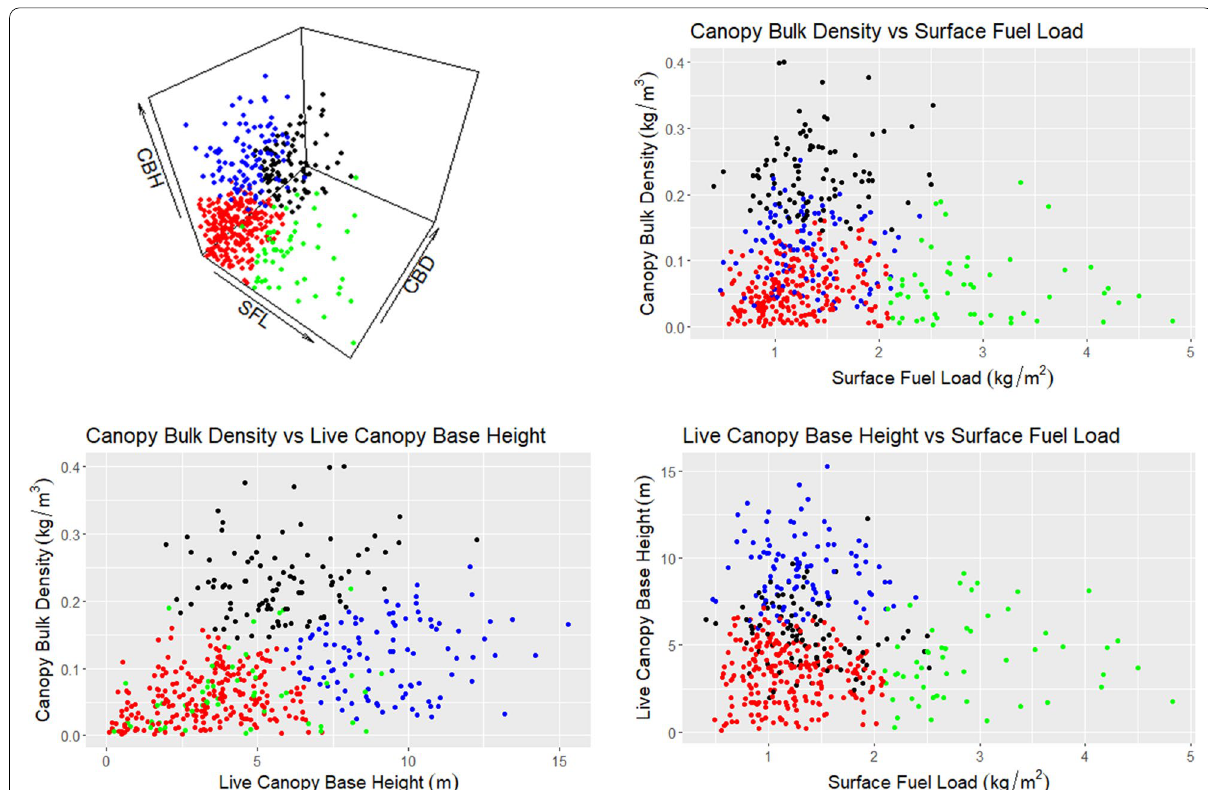
Fig. 1 Scatter plots of surface fuel load (SFL), live canopy base height (CBH), and canopy bulk density (CBD), and corresponding fuel class cluster (FCC) membership denoted by red, blue, black, and green colour